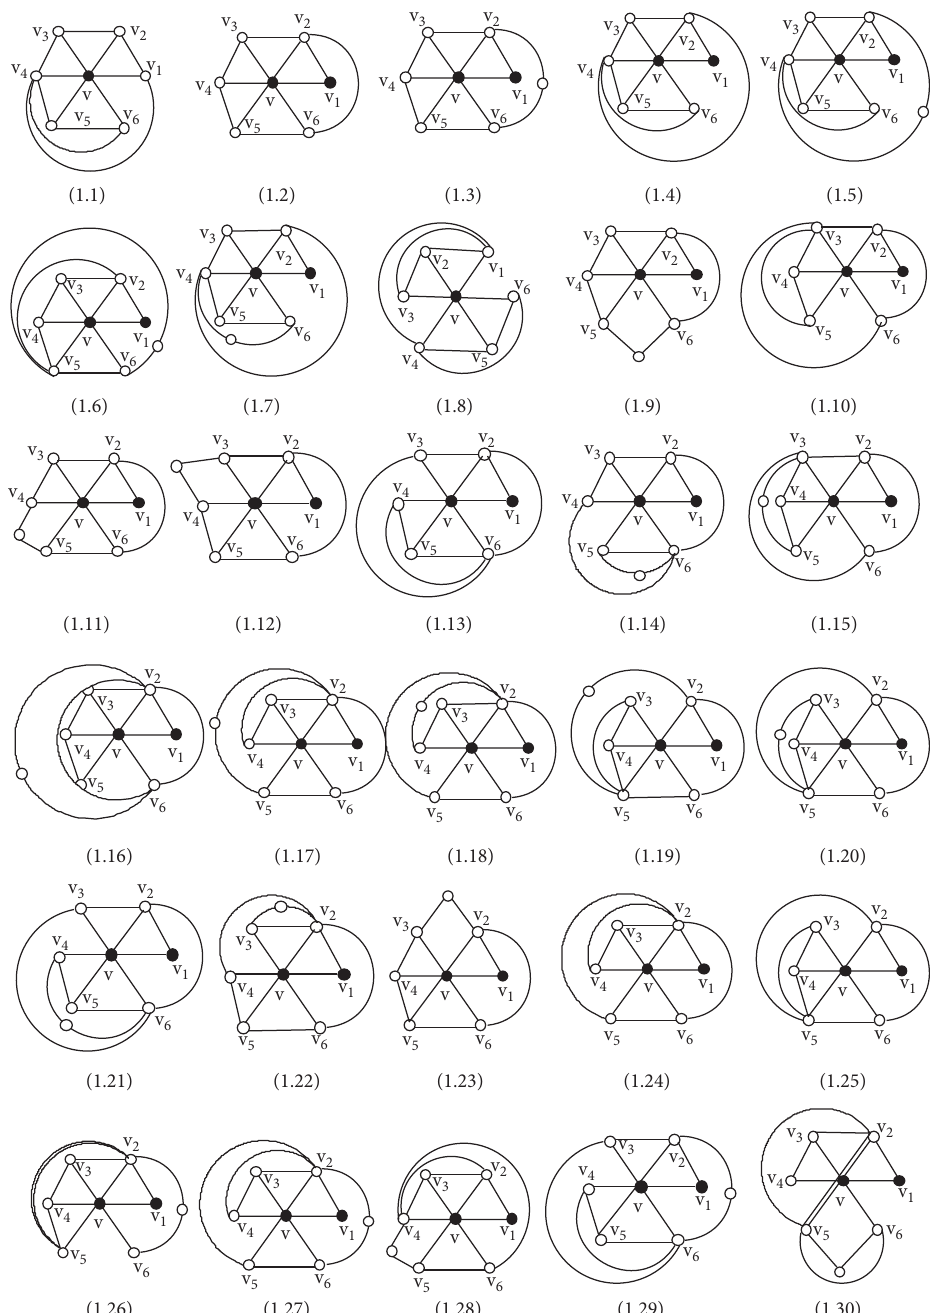
Figure 1: Black vertices do not have neighbors other than those presented in the picture; white vertices can be adjacent to some other